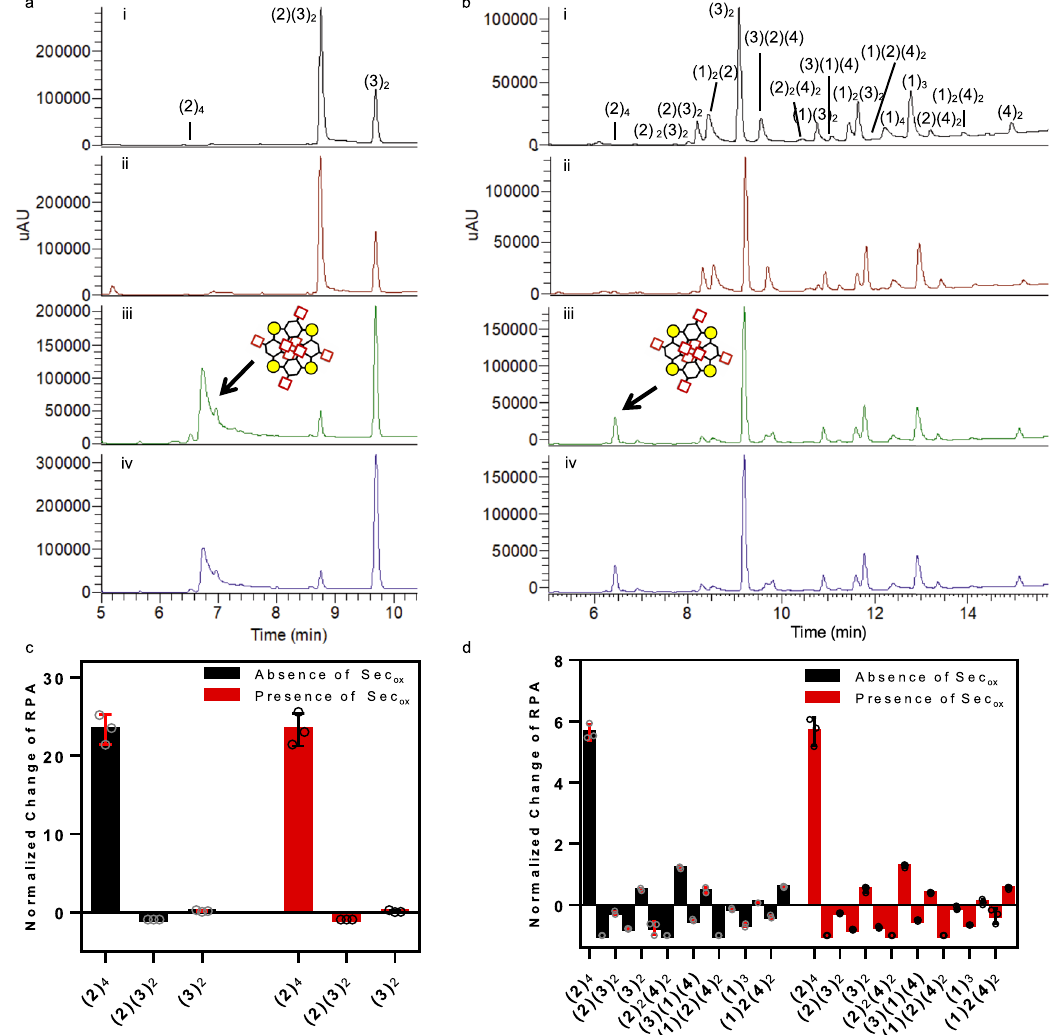
Fig. 8 Spermine-templated DCL. a DCL chromatograms of building block 2 (95 μ M) and 3 (190 μ M) in the absence and presence of spermine (28.5 μ M). Yellow circle (S – S), red square (CO 2 H), black hexagon (benzene ring). DCL conditions: Tris buffer 20 mM pH 7.8, 6 °C, 2.5% DMSO. (i) control in absence of spermine after 96 h (black), (ii) in the absence of spermine but with Sec ox (5% mol, 14.25 μ M) 24 h (red), (iii) control in presence of spermine after 96 h (green), (iv) in the presence of spermine and 5% mol Sec ox 24 h (blue). b DCL chromatograms of building blocks 1 – 2 (95 μ M each) and 3 – 4 (190 μ M each), in the absence and presence of spermine (57 μ M), Sec ox (5% mol, 28.5 μ M), Tris buffer (20 mM, pH 7.8), T = 6 °C, 2.5% (v/v) DMSO. (i) control in absence of spermine 96 h (black), (ii) in the absence of spermine but with Sec ox (5%, mol 28.5 μ M) 24 h (red), (iii) control in presence of spermine 96 h (green), (iv) in the presence of spermine and 5% mol Sec ox 24 h (blue). c Spermine template effect measured by the normalized change of RPA in the presence and absence of Sec ox for building blocks 2 and 3 . d Spermine template effect measured by the normalized change of RPA in the presence and absence of Sec ox for building blocks 1 – 4 . See Supplementary Tables 3 – 6. Mean ± SD from three independent